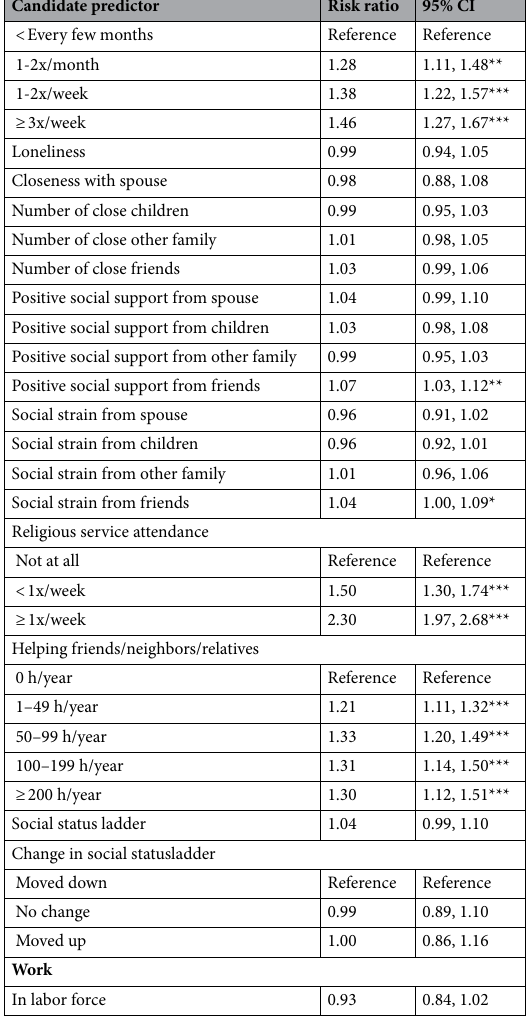
Table 2. Candidate predictors of volunteering (volunteering vs. no volunteering) (Health and Retirement Study [HRS]: N = 13,771) a,b,c . CI, confidence interval; RR, risk ratio. * P < .05 before Bonferroni correction; ** P < .01 before Bonferroni correction; *** P < .05 after Bonferroni correction (the P value cutoff for Bonferroni correction is P = .05/61 predictors = P < .00081968). a The analytic sample was restricted to those who had participated in the pre-baseline wave (2006 or 2008). Multiple imputation was performed to impute missing data on the exposures, covariates, and outcome. Candidate antecedents were assessed, one at a time, in wave 2 (2010/2012), and the outcome (volunteering) was assessed in wave 3 (2014/2016). The following covariates were controlled for at wave 1 (2006/2008): sociodemographic characteristics (age, sex, race/ethnicity, marital status, income, total wealth, level of education, health insurance, geographic region), childhood abuse, personality factors (openness, conscientiousness, extraversion, agreeableness, neuroticism), and all of the predictor variables, including: health behaviors (physical activity, smoking, heavy drinking, sleep problems), physical health (heart disease, cancer, stroke, arthritis, hypertension, overweight/obese, diabetes, lung disease, chronic pain, hearing, eyesight, self-rated health, physical functioning limitations, cognitive impairment), social factors (live with spouse, frequency of contact with children, frequency of contact with other family, frequency of contact with friends, loneliness, closeness with spouse, number of close children, number of close other family, number of close friends, positive social support from spouse, positive social support from children, positive social support from friends, positive social support from other family, social strain from spouse, social strain from children, social strain from other family, social strain from friends, religious service attendance, volunteering, helping friends/neighbors/relatives, perceived social status, change in perceived social status), psychological well-being factors (life satisfaction, positive affect, purpose in life, optimism, health mastery, financial mastery, mastery), psychological distress (depressive symptoms, hopelessness, negative affect, constraints, anxiety, trait anger, state anger, daily discrimination, major discrimination, cynical hostility, stressful life events, financial strain), and work (in labor force). b All continuous candidate antecedents were standardized (mean = 0; standard deviation = 1). c An exposure-wide analytic approach was used, and a separate model for each exposure was run. Because volunteering was a binary outcome with a prevalence of ≥ 10%, we ran a generalized linear model with a log link and Poisson distribution to estimate a